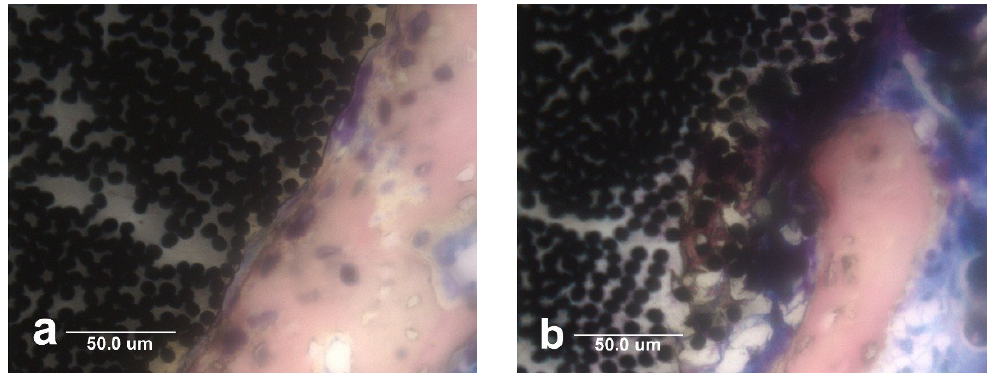
Figure 10. Horizontal cross-sectional histology with Sanderson’s stain at 40×